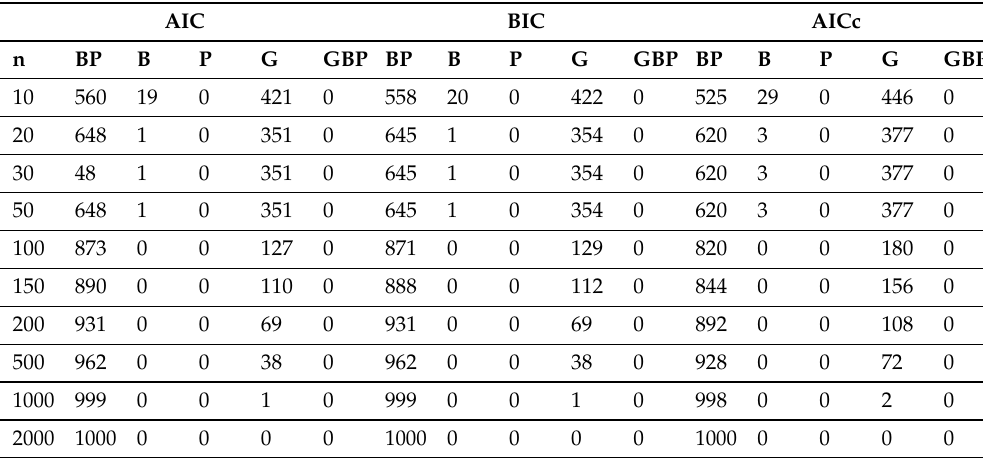
Table 10. Smaller AIC/BIC/AICc scores in 1000 simulations from a BP distribution BP ( α , β , k , θ